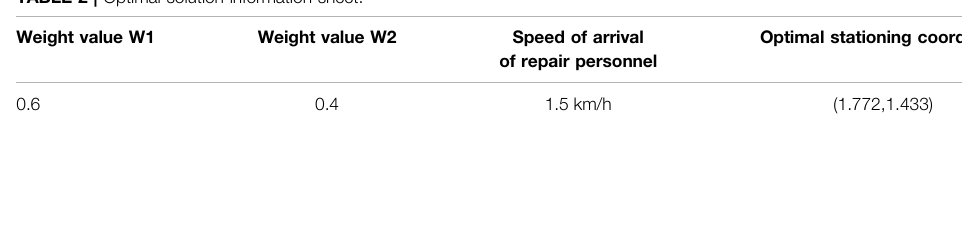
TABLE 2 | Optimal solution information